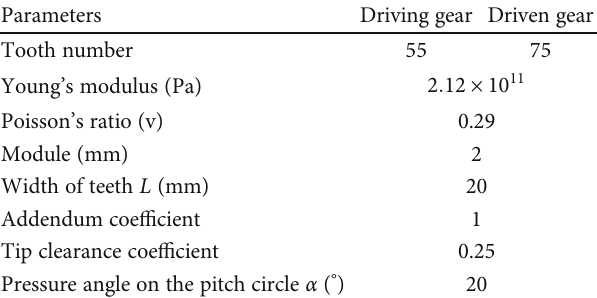
Table 1: Basic parameters of gear pair.